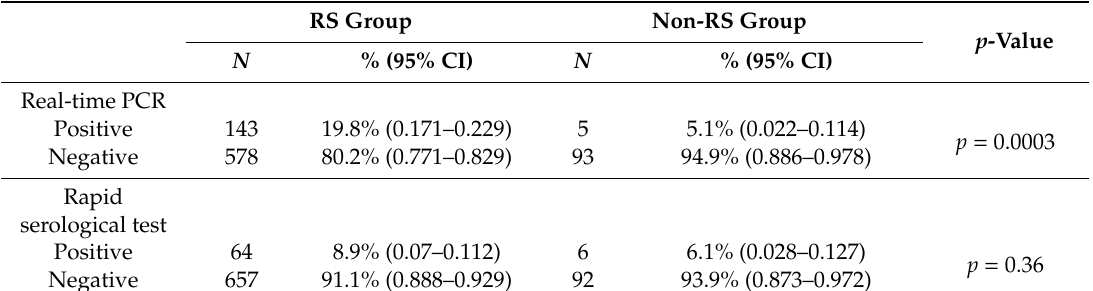
Table 3. Results of serological and molecular tests for SARS-CoV-2 of all patients enrolled.